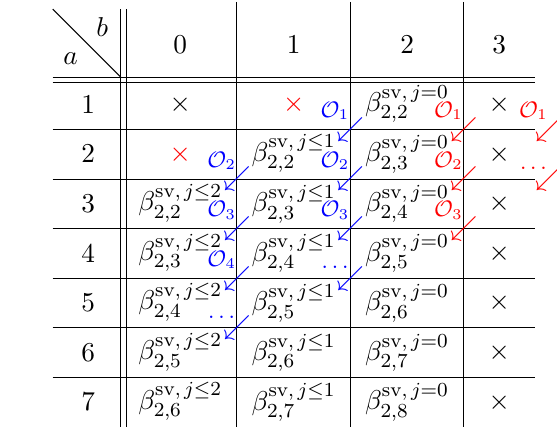
Table 8 . Filling in the chessboard with the action of the operators O ‘ defined in (3.63).